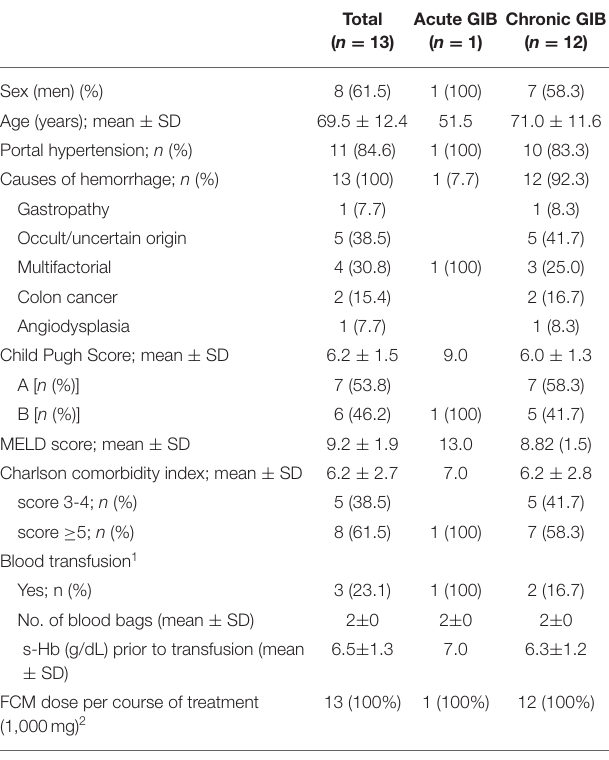
TABLE 3 | Clinical characteristics of outpatients ( n =